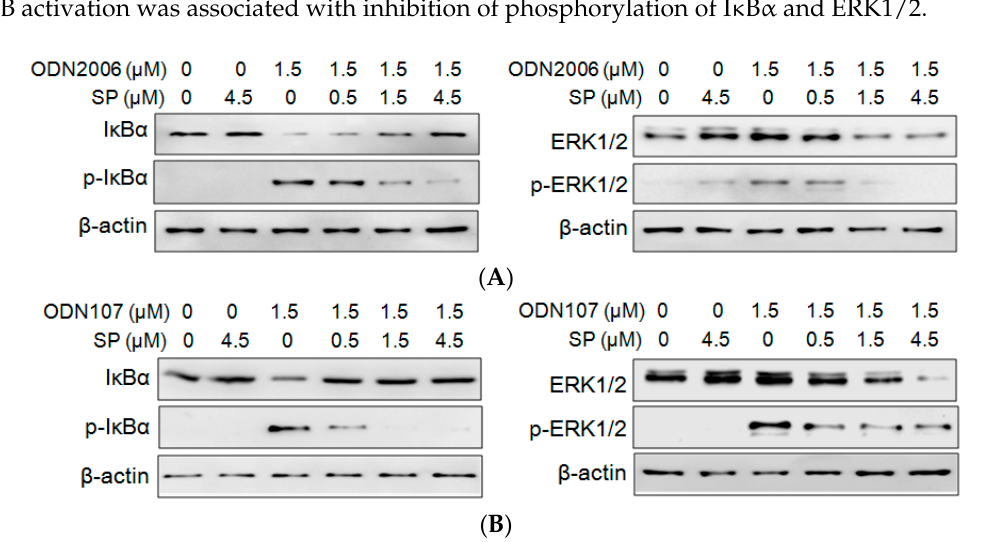
Figure 4. Synthetic peptide (SP) decreased the phosphorylation of I κ B α and ERK1/2 in RAW264.7 cells treated with CpG oligodeoxynucleotides (CpG ODN). RAW264.7 cells (1.0 × 10 7 cells) grown in 10-cm dishes were treated with 1.5 μ M of ODN2006 ( A ) or ODN107 ( B ) pre-incubated with SP (0, 0.5, 1.5, or 4.5 μ M) at 37 °C for 15 min. After incubation for 4 h, cells were harvested to extract total protein; and the protein expressions of I κ B α , phosphorylated (p)-I κ B α , ERK1/2 and p-ERK1/2 were detected by western blotting. Data from one of three independent experiments are shown.